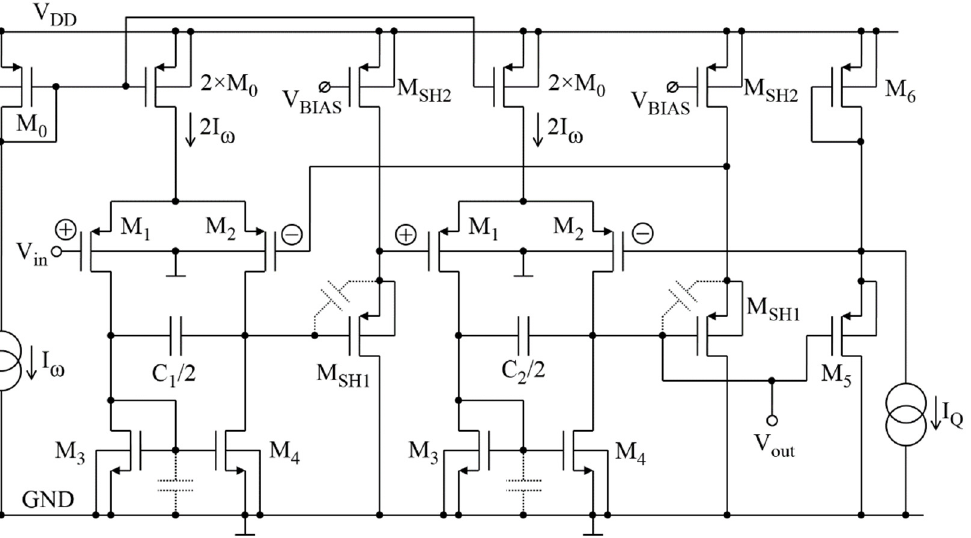
Figure 4. Transistor ‐ level implementation of the filter in Figure 2.